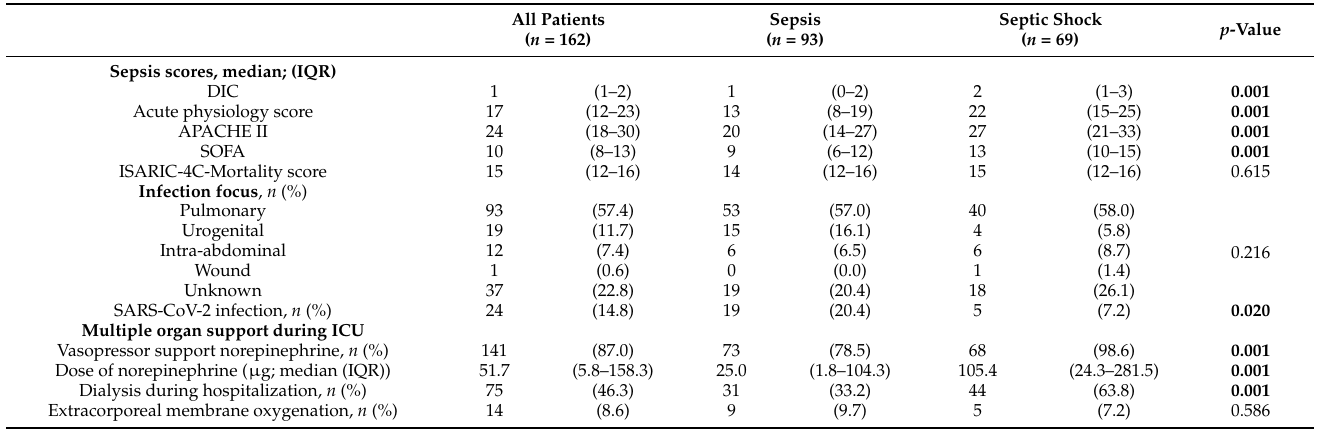
Table 2. Sepsis-related data, follow-up data and